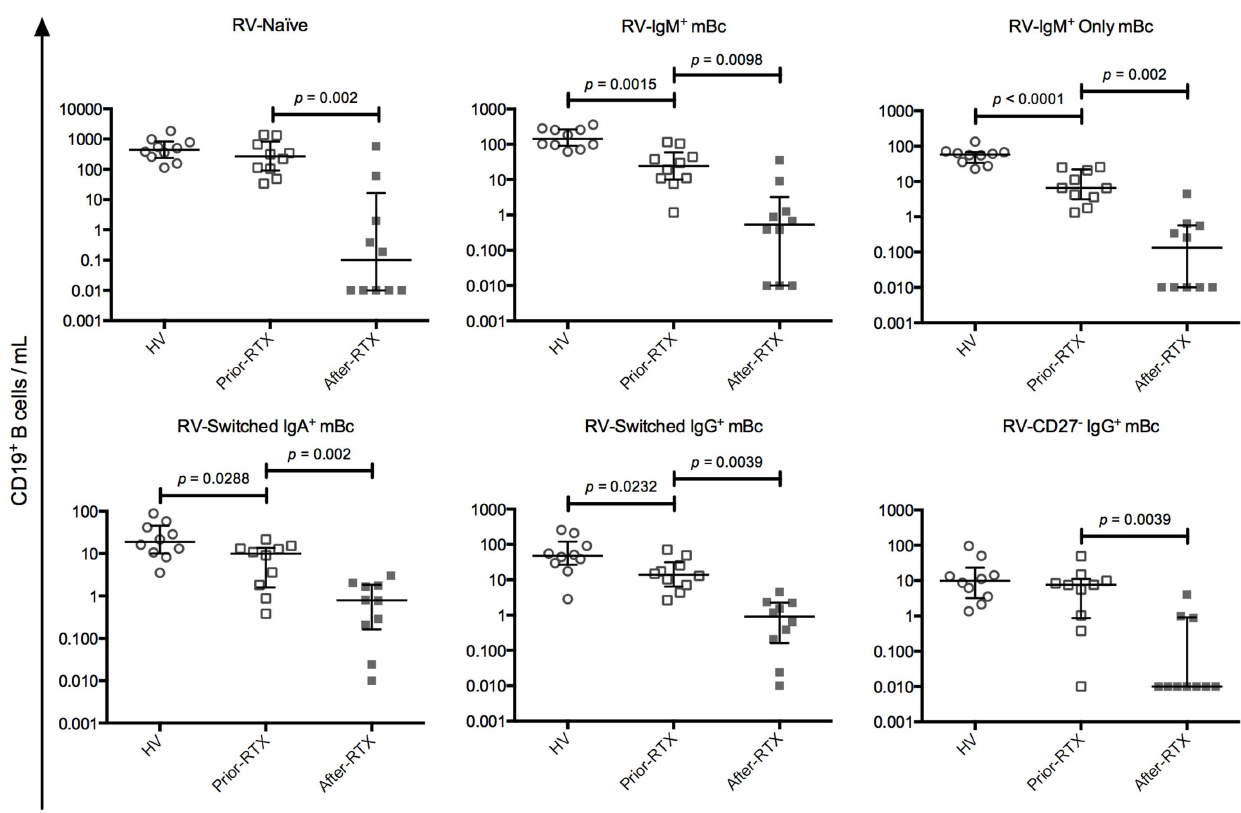
Figure 3. Comparison of RV-specific B cell subpopulations among the study groups. Solid lines and error bars denote the median and interquartile range, respectively. Differences between HV (n=10) and patients prior-RTX (n=10) were evaluated with Mann–Whitney tests and between patients prior-RTX and patients after-RTX (n=10) with Wilcoxon tests. All p values reported are 2-tailed.